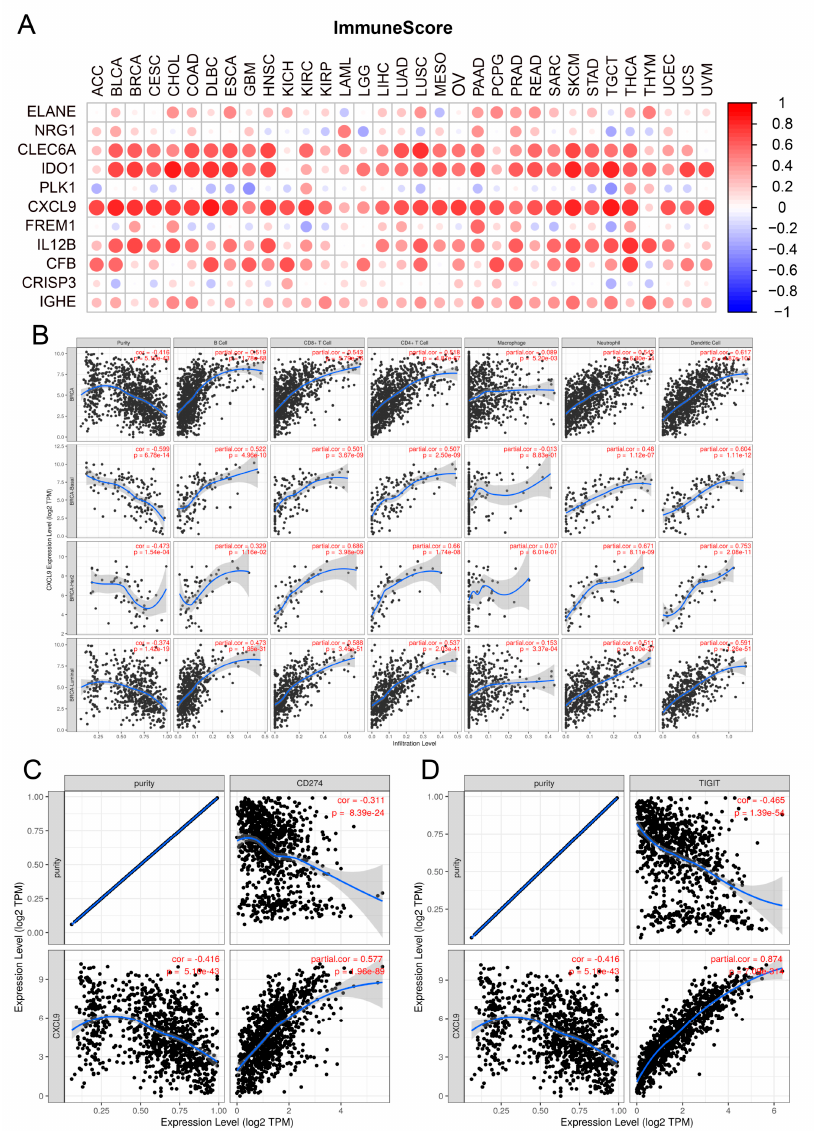
Figure 6. Immune cell infiltration analysis for innate prognostic biomarkers through transcriptome profile. Comparison of the correlation of the expression of 11 innate immune prognostic biomarkers and the levels of immune score ( A ) of multiple cancer patients through the transcriptome profile. ( B ) Analysis for the correlation of the expression of CXCL9 and the abundance of immune cell infiltration in breast cancer patients through TIMER database. The expression of CXCL9 exhibited significant negative correlation with the key checkpoint CD274 ( C ) and TIGIT ( D ) in breast